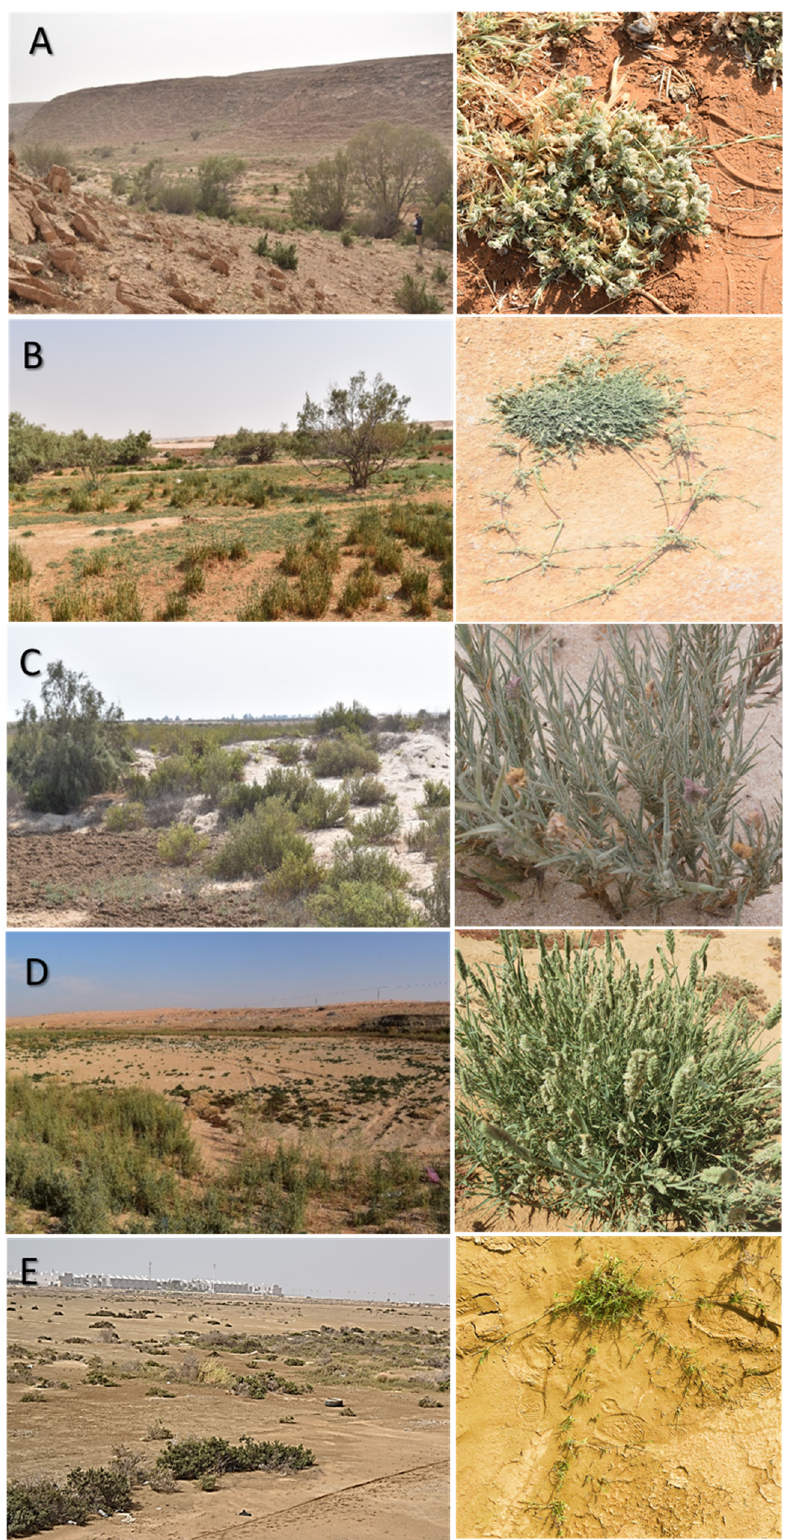
Figure 1. Different studied flat saline regions, ( A ) Qareenah, ( B ) Qaseem, ( C ) Salwa, ( D ) Jouf, and ( E ) Jizan. The left is an overview, and the right is a close view of A. lagopoides .